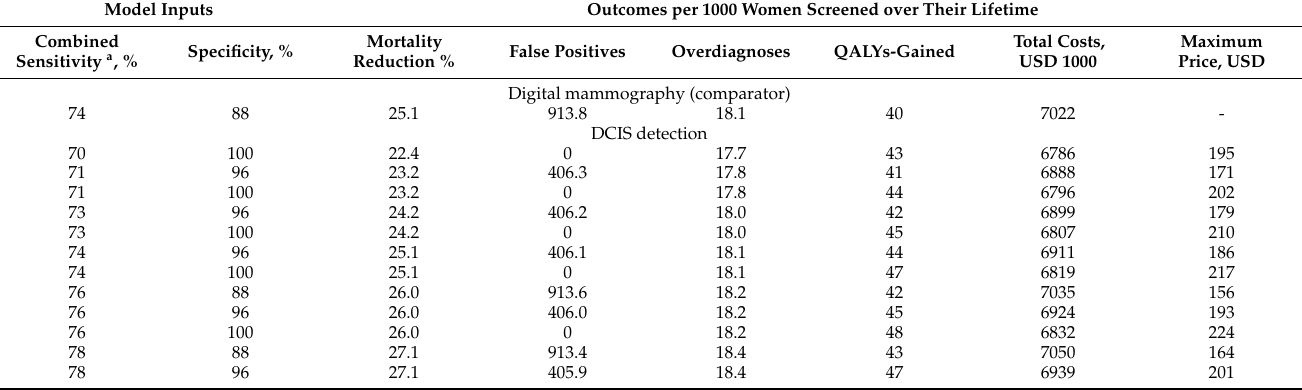
Table 4. Outcomes for routine screening with liquid